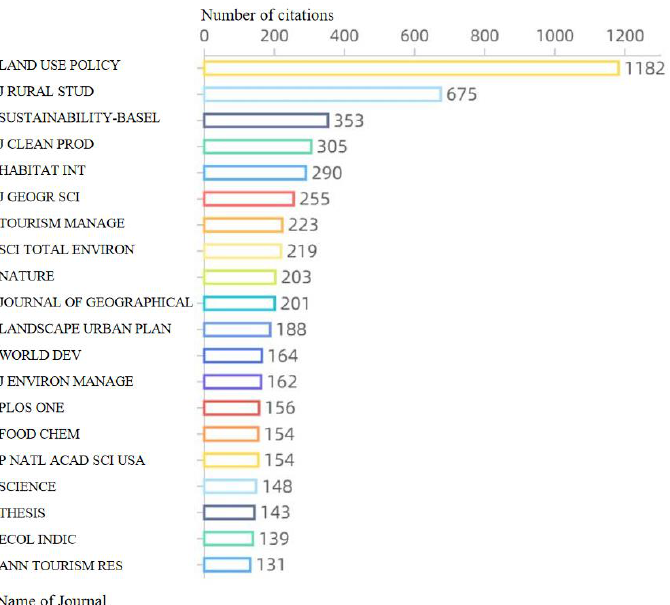
Figure 3. Citation sources and citations in the field of rural revitalization from 1991 to 2021. Note: The full names of the journals in the figure are as follows: Land Use Policy , Journal of Rural Studies ,